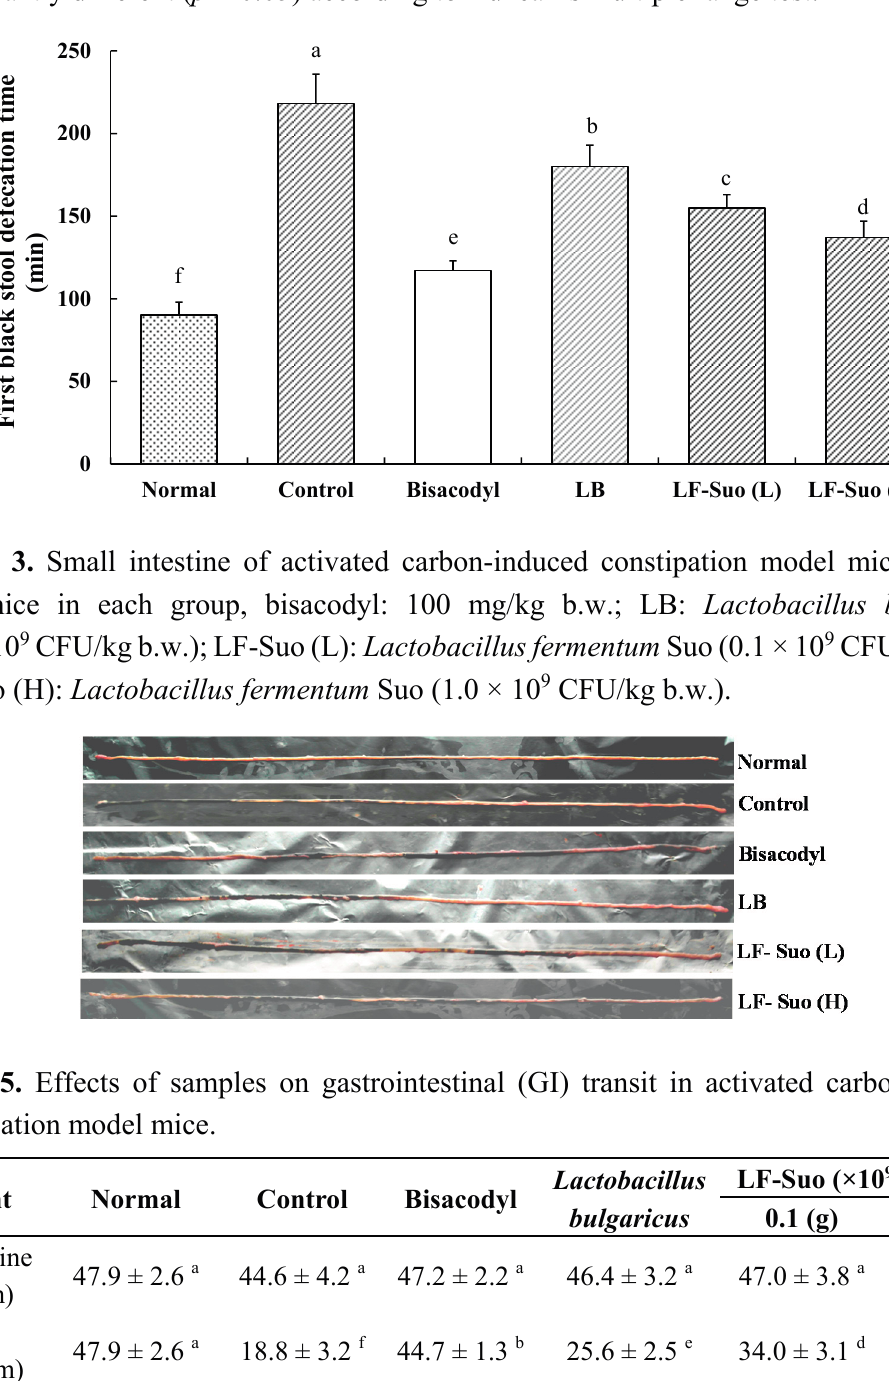
Figure 2. First black stool defecation time of mice after inducing constipation by activated carbon at the last day in the experiment. n = 10 ICR mice in each group, bisacodyl: 100 mg/kg b.w.; LB: Lactobacillus bulgaricus (1.0 × 10 9 CFU/kg b.w.); LF-Suo (L): Lactobacillus fermentum Suo (1.5 × 10 9 CFU/kg b.w.); LF-Suo (H): Lactobacillus fermentum Suo (1.0 × 10 9 CFU/kg b.w.); a–f Mean values with different letters over the bars are significantly different ( p < 0.05) according to Duncan’s multiple range test.